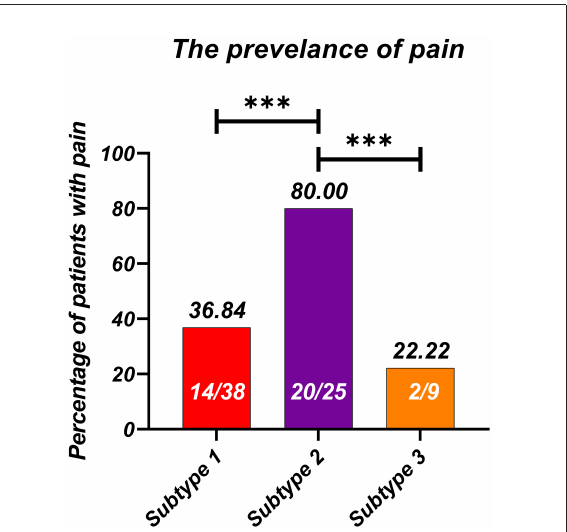
FIGURE6 The incidence of foot pain in each radiographic subtype. *** P < 0.001.